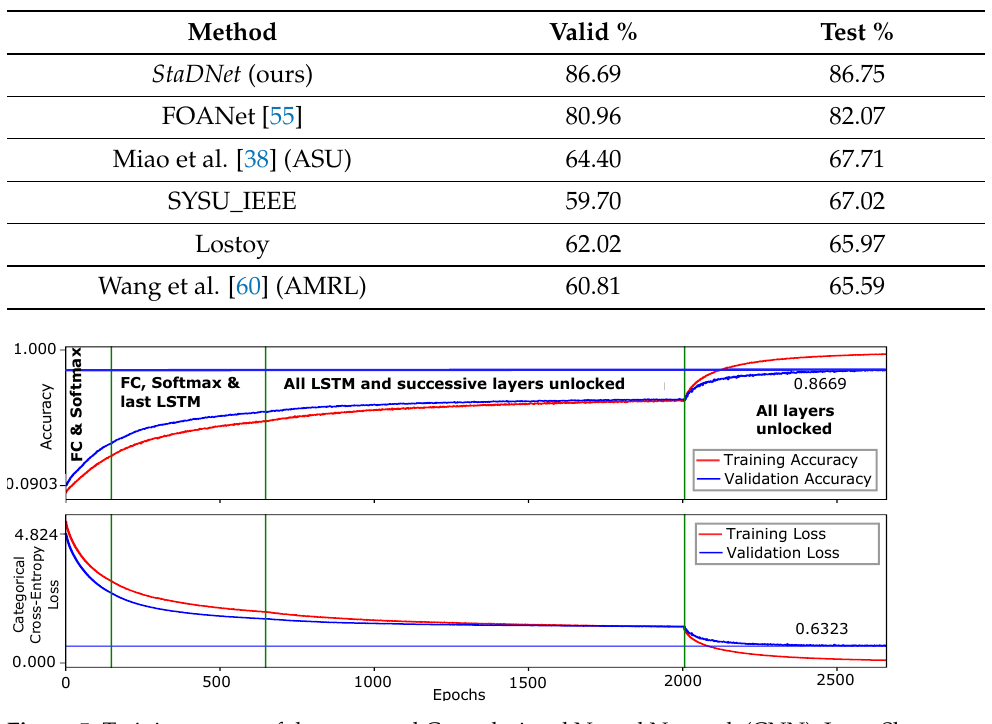
Figure 5. Training curves of the proposed Convolutional Neural Network (CNN)–Long Short term Memory (LSTM) network for all 249 gestures of the Chalearn 2016. The network is trained in four phases, distinguished by the vertical